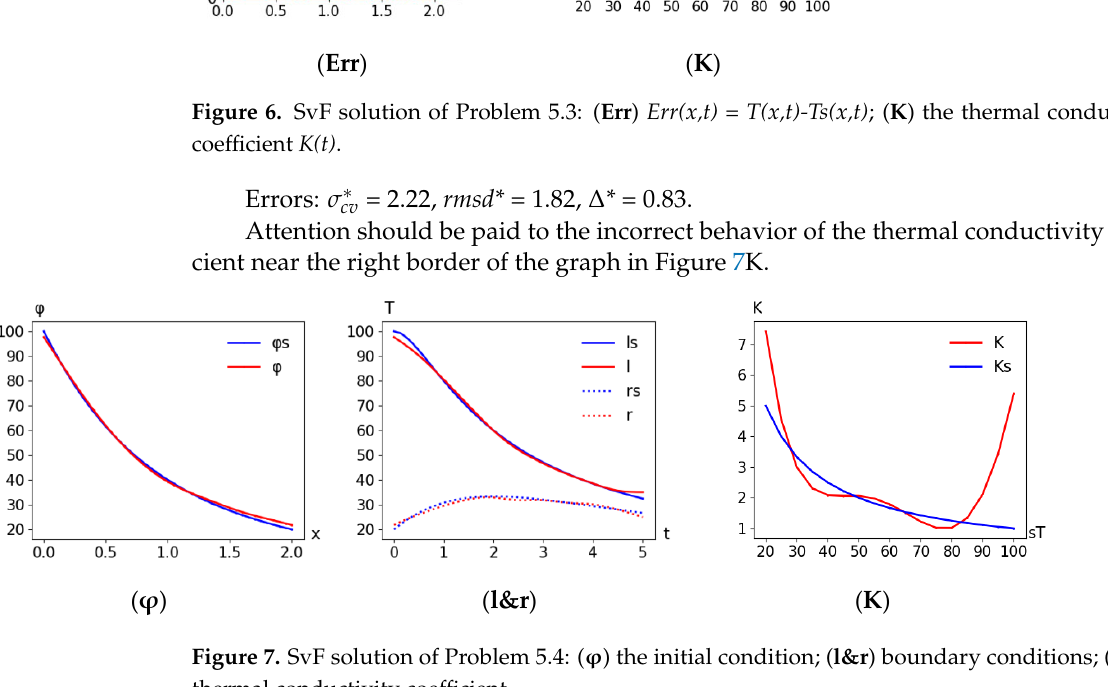
Figure 6. SvF solution of Problem 5.3: ( Err ) Err(x,t) = T(x,t)-Ts(x,t) ; ( K ) the thermal conductivity co- efficient K(t) .